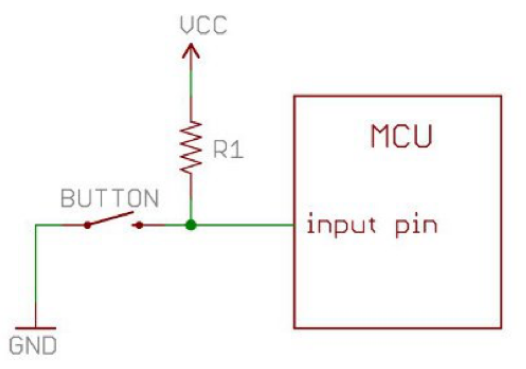
Figure 7. Schematic of connecting a button to a microcontroller with a pull-up resistance, that is, normally High when not pressed. If the button is pressed, GND forces the logic level ’0’ (zero) at the input of the microcontroller.